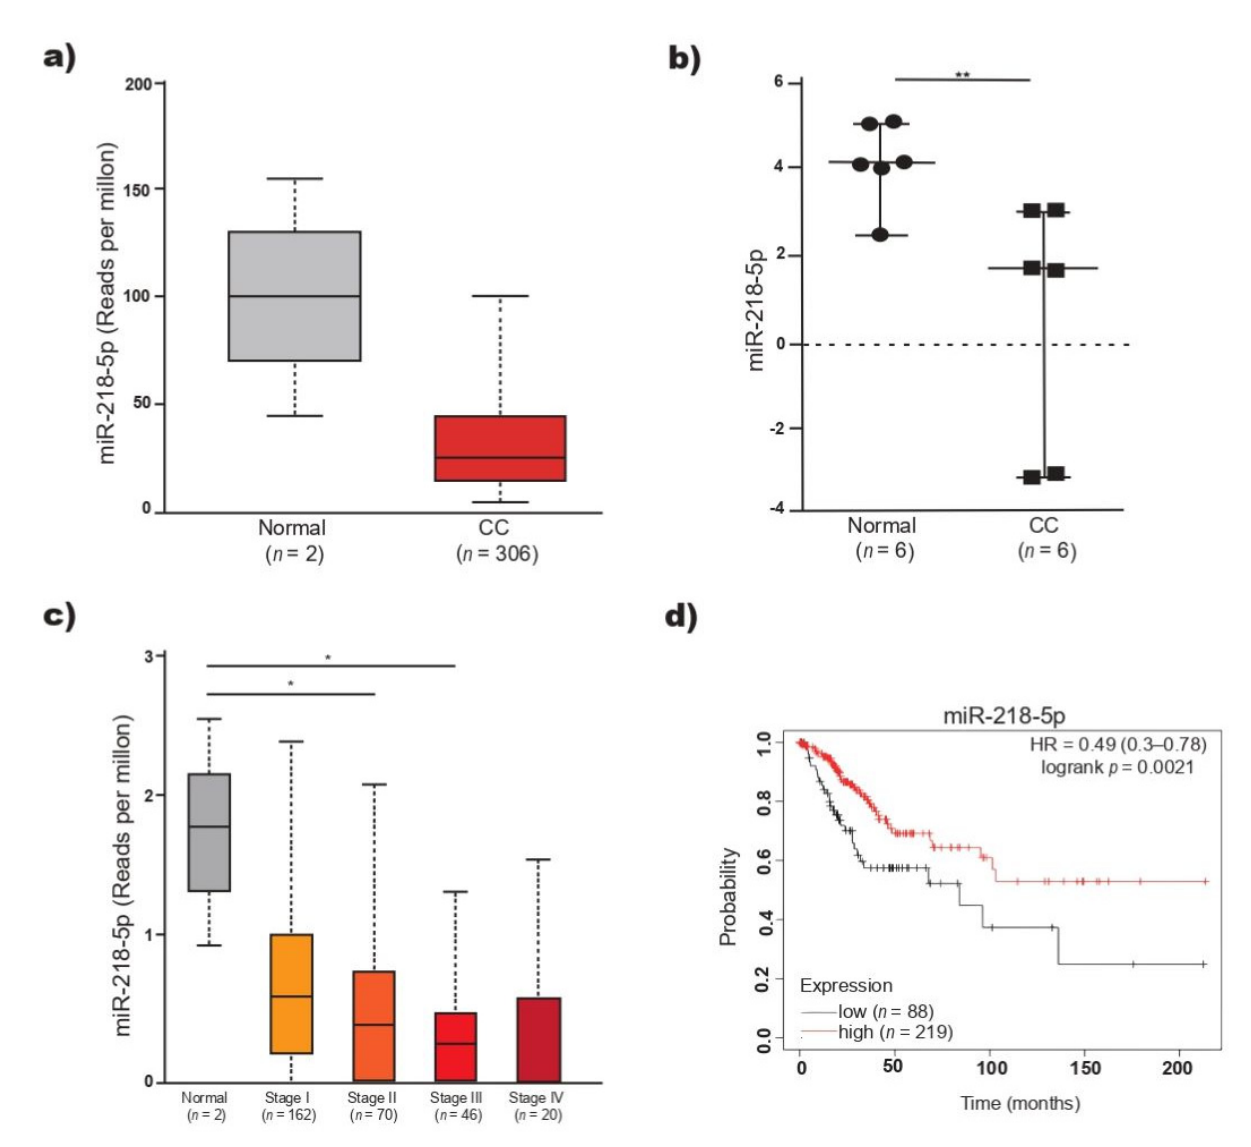
Figure 1. Expression and prognostic value of miR-218-5p in CC. ( a ) miR-218-5p expression in CC and normal tissues (TCGA data), ( b ) miR-218-5p expression in the GSE86100 dataset, including samples of squamous cell carcinoma positive for HPV16 and normal tissues (healthy uninfected cervix), ( c ) miR-218-5p level for tumor stage in CC, based on FIGO criteria, ( d ) Kaplan–Meier survival curve, the red line represents the patients with high expression of miR-218-5p and the black line represents the patients with low expression of miR-218-5p. miR-218-5p expression was significantly related with overall survival (OS) of CC patients (TCGA data). * p < 0.05, ** p < 0.01.